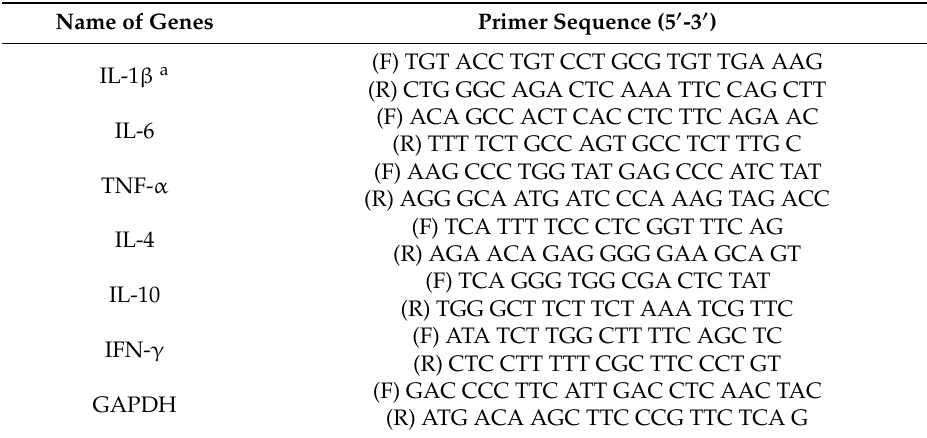
Table 1. Primer sequences used in the current